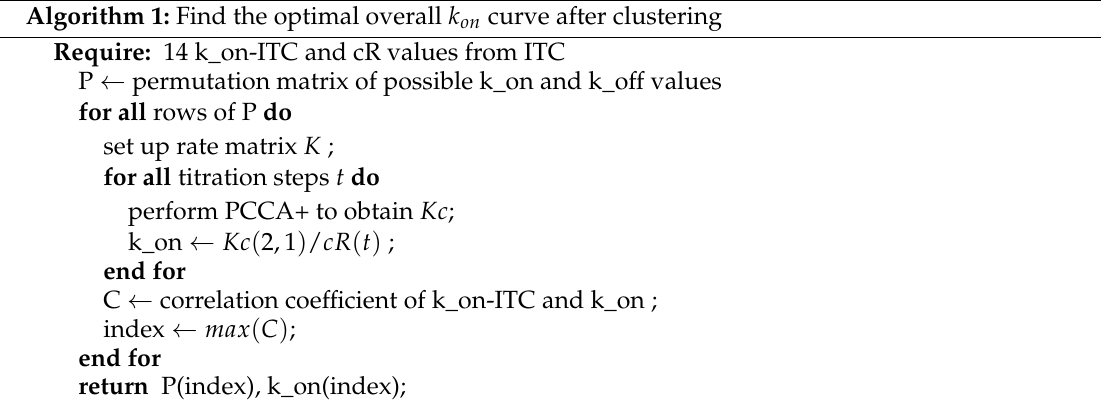
Algorithm 1: Find the optimal overall k on curve after